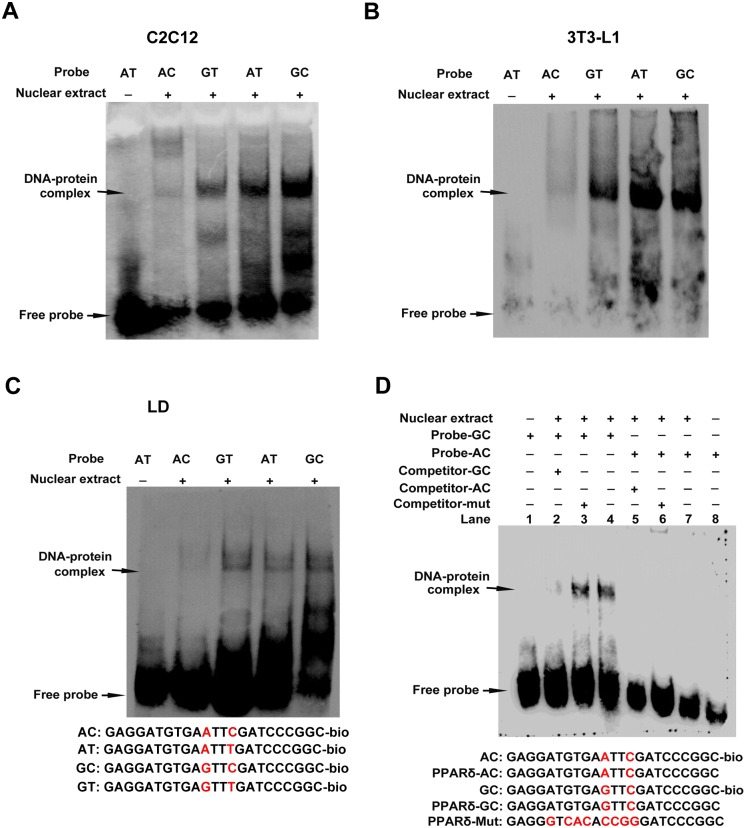
Nuclear extracts differentially bind to the promoter fragments carrying the four haplotypes.(A) (B) (C) EMSA results showing the binding capacities of four haplotypes to the nuclear extracts in C2C12 myoblasts, 3T3-L1 cells, and porcine LD muscle. (D) The EMSA results showing the binding capacities of nuclear extracts to the promoter fragments with haplotypes AC and GC, Lane 1 and Lane 8 were negative control; Lane 2–4 and 5–7 in turn were sample reactions, mutation competitive reactions, and cold competitive reactions for AC and GC reaction groups, respectively. The probes were incubated with nuclear extracts in the absence or presence of 1-fold excess of various competitor probes (mutant or non-labeled probe). The specific DNA-protein complex bands were indicated by arrows. The sequences of various probes were shown under the panel.